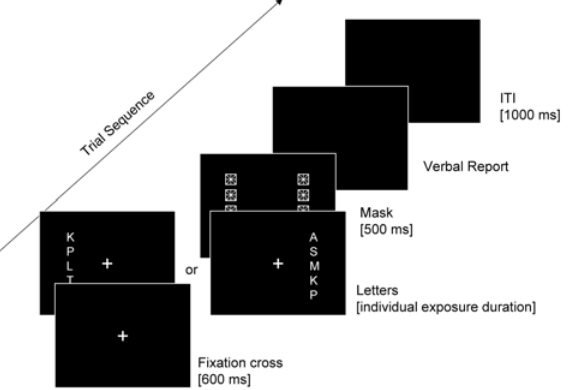
Figure 2. Sequence of frames on a given trial of the TVA based whole-report